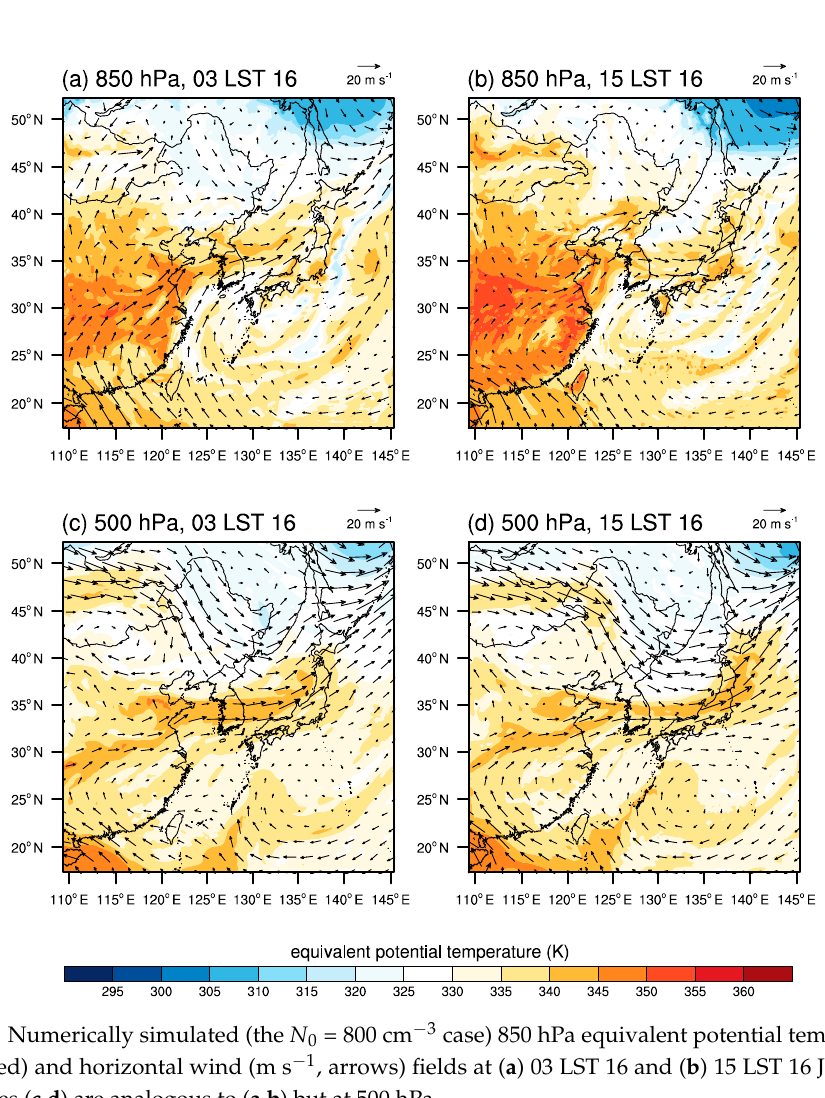
Figure 3. Numerically simulated (the N 0 = 800 cm − 3 case) 850 hPa equivalent potential temperature (K, shaded) and horizontal wind (m s − 1 , arrows) fields at ( a ) 03 LST 16 and ( b ) 15 LST 16 July 2017. Subfigures ( c , d ) are analogous to ( a , b ) but at 500 hPa.